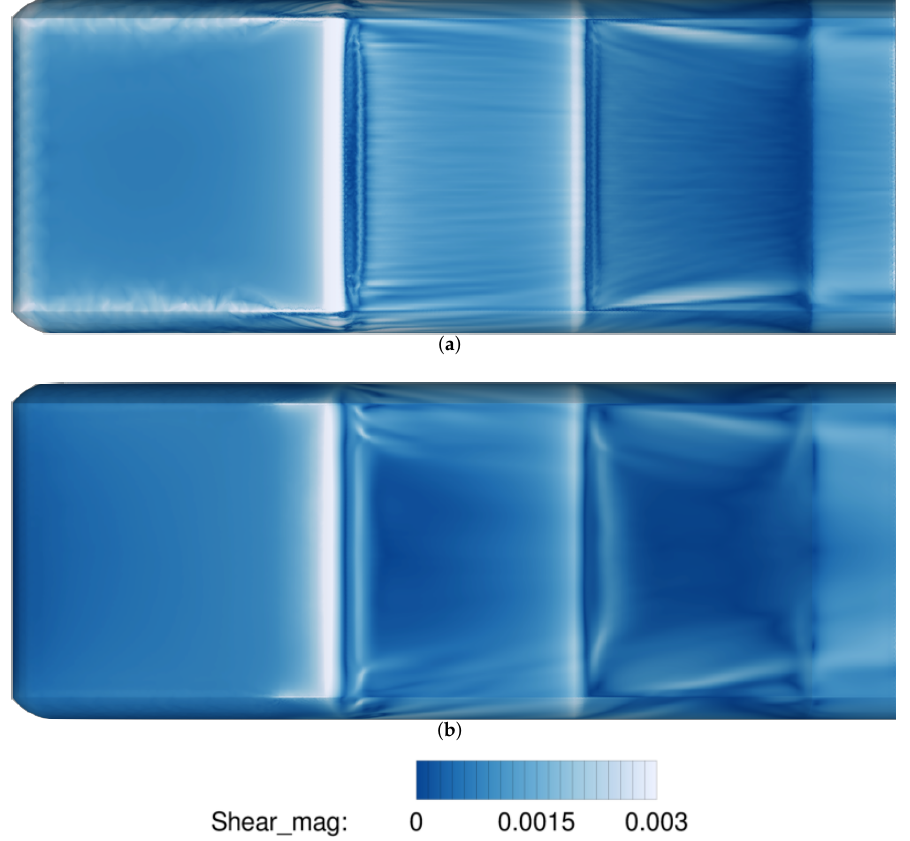
Figure 8. Wall-shear stress (0.5*Cf) contours. ( a ) HCP5 and ( b ) HFP3. Figure 9 shows the backlight and base pressure for both HCP5 and HFP3 as well as a comparison with the RANS values. The pressure distribution over the slant is perturbed along a line of low-pressure values near the outboard edge, which is an effect of the trailing vortex. This line of low-pressure values extends further downstream in the HFP3 case whereas the extent of the perturbation is more moderate in the RANS and HCP5 cases. As expected, the negative Cp region associated with the separation at the top of the backlight is larger in the HFP3 case than both the RANS and HCP5. Both Cp peaks at the base of the slant due to impingement on the bootlid are of a higher magnitude in the spectral/hp element simulations than RANS. The spanwise expansion of this hig- pressure zone is constrained by the low-pressure line of the C-pillar vortex and is furthermore more limited in the HFP3 case. For this particular case, the pressure peak vanishes when approaching the symmetry plane, leading to lower pressure values compared with HCP5 at the base of the backlight, already highlighted on Figure 6. HFP3 consequently better agrees with the lower backlight Cp values with a higher value around the bootlid seen in the HCP5 case. The base pressures in both cases are similar. The bottom region with lower- pressure values corresponds to the diffuser. Lower Cp values over the diffuser indicate a predominantly attached flow compared with higher values in high-order simulations. The flow separates later on the diffuser in the HCP5 case compared with the HFP3 indicated by the pressure recovery ending at a higher